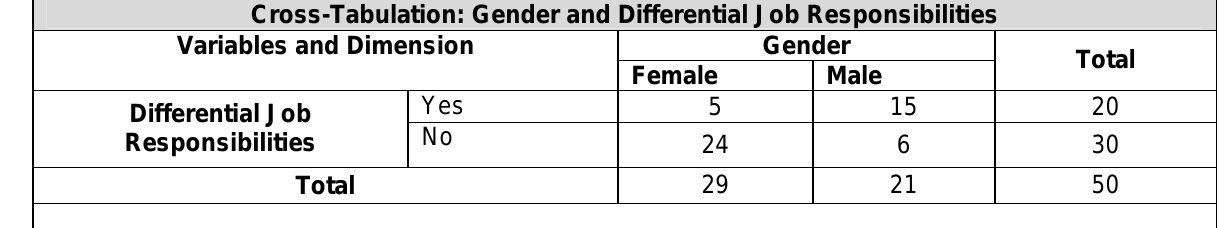
Table 2: Gender and differential job responsibilities Cross-Tabulation: Gender and Differential Job Responsibilities